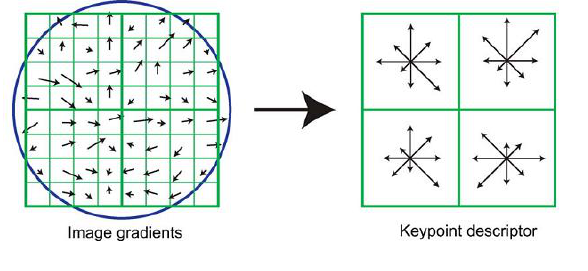
Figure 2. calculate the descriptor